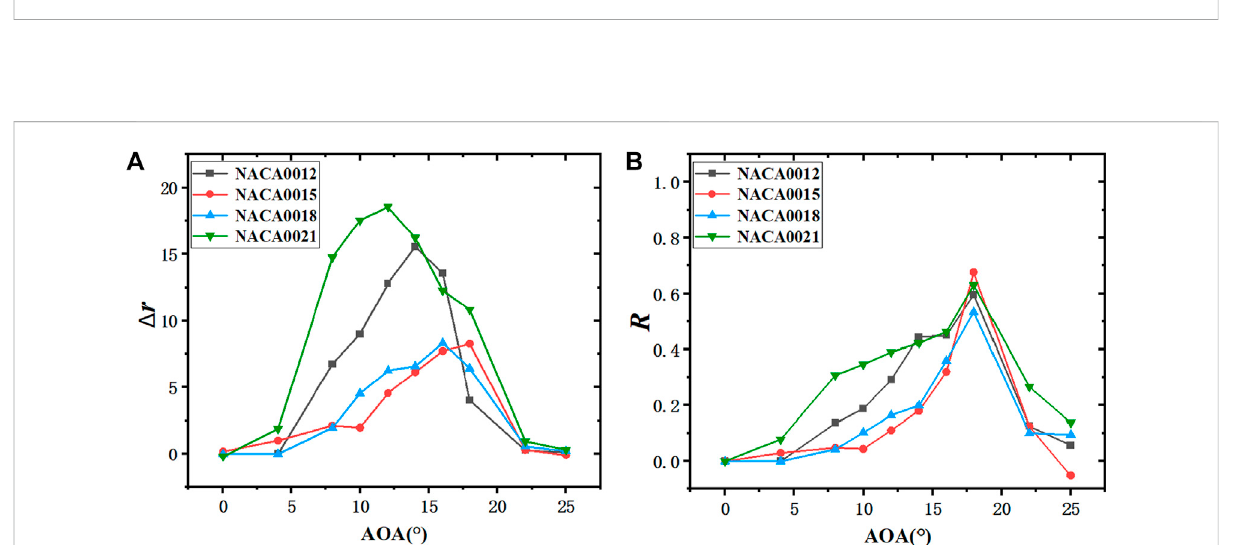
FIGURE 11 Difference of lift-drag ratio between original airfoil with different thickness and semi-circular leading edge erosion airfoil ( h 1 = 0.5% c ). ( (A) : Absolute difference in the lift-drag ratio; (B) : Relative difference in the lift-drag